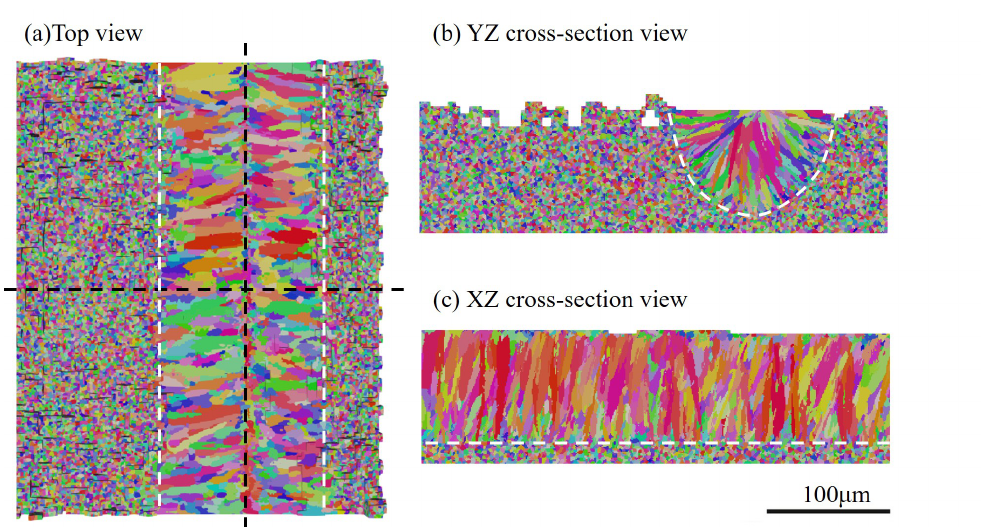
Figure 9. Several 2D views of the single-track simulation results: ( a ) top view of CA result, ( b ) trans- verse cross-section map of CA, and ( c ) longitudinal cross-section map of CA result, where white dotted lines represent the boundary of the melting zone and black dotted lines represent the locations of the